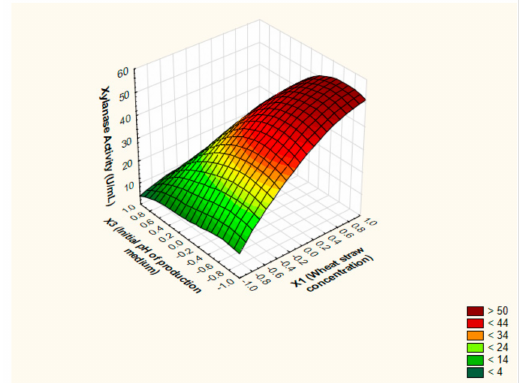
Figure 5. The 3D surface plot depicting the impact of WS concentration (%( w / v )) and initial pH of the production medium at fixed value of yeast extract concentration (%( w / v )) on the xylanase